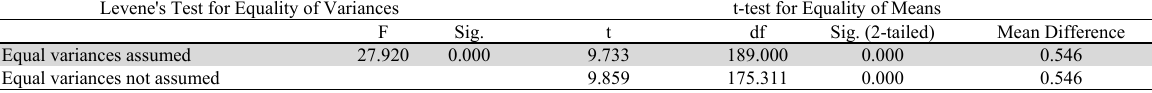
The result of the independent sample t-test for Sexual Misconduct Levene's Test for Equality of